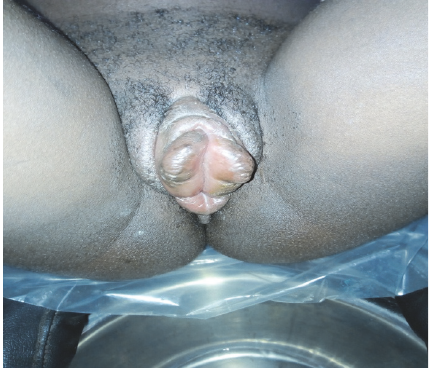
Figure 1: The vulvar edema in day 6.